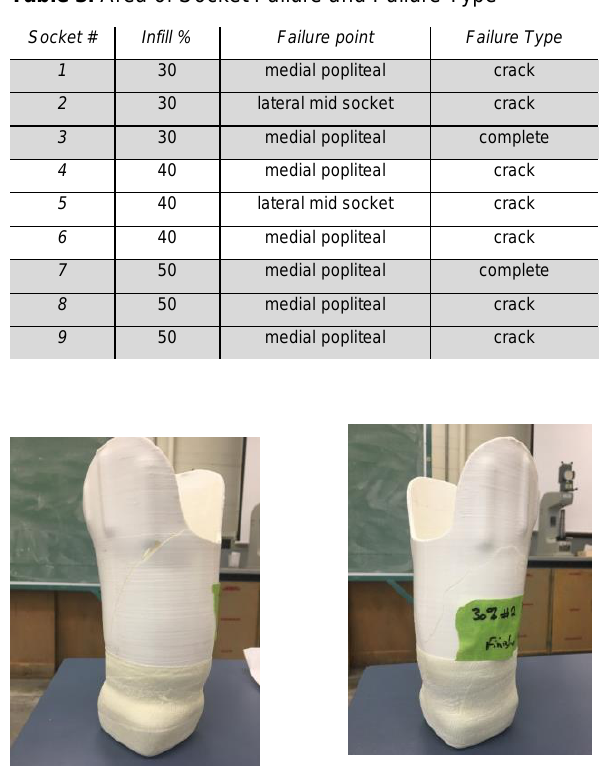
Figure 6. Left : Socket broken in the medial popliteal area; Right: Socket broken in the middle lateral area.